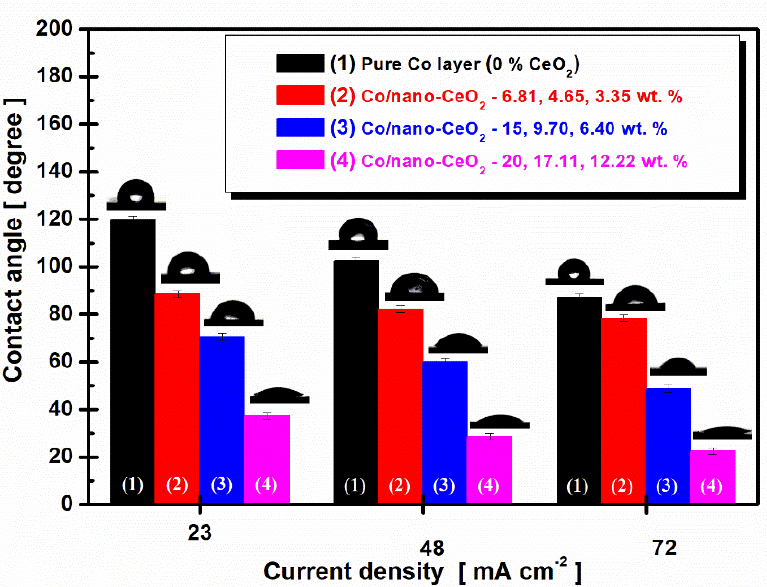
Figure 7. Variation of contact angle according to current density at deposition times of 90 min for: ( 1 ) pure Co layer (0% CeO 2 ), ( 2 ) Co/nano-CeO 2 —10 g/L layer (6.81, 4.65, and 3.35 wt. %), ( 3 ) Co/nano-CeO 2 —20 g/L layer (15, 9.70, and 6.40 wt. %), and ( 4 ) Co/nano-CeO 2 —30 g/L layer (20, 17.11, and 12.22 wt. %).